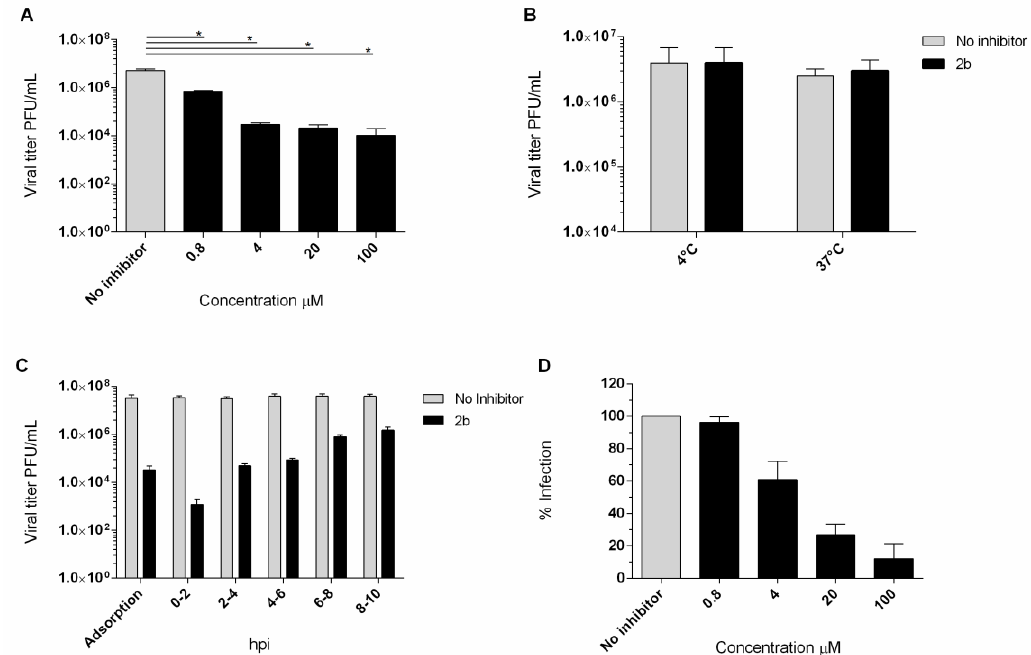
Figure 4. ( A ) Yield of infectious EV-A71 viruses produced in infected Vero-76 cells treated with 2b and NM 107. Vero-76 cells were infected with EV-A71 (m.o.i. 0.1). The infected cultures were treated with 2b , at indicated doses. Viral yields in the culture supernatant were determined by a plaque assay at 96 h post-infection. * Statistically significant differences are expressed ( p < 0.05). ( B ) Virucidal effect (expressed as plaque-forming units (PFU/mL) of derivative 2b (20 µM) against EV-A71 virions at either 4 °C or 37 °C for 1 h. Dark columns, viral titer for viral and derivative 2b solution; white columns for the viral titer of the untreated solution. ( C ) Adsorption assay and time course experiment. Vero-76 cells were pre-adsorbed for 1 h at 4 °C with viruses at an m.o.i. = 1 in the presence of the compound (5 × EC 50 concentration). Vero-76 cells were inoculated with EV-A71 (m.o.i. = 1) and then compound 2b (20 µM) was added at the indicated times. Viral yields were determined by a plaque assay. Dark columns, the viral yield for control cells; gray columns; viral yield for cells treated with 2b derivative. ( D ) Penetration assay. Dose-dependency of derivative 2b (dark columns) in reduction in EV-A71 penetration compared to non-treated sample control (gray columns). The results presented were obtained from three independent experiments. Data are mean ±SD.